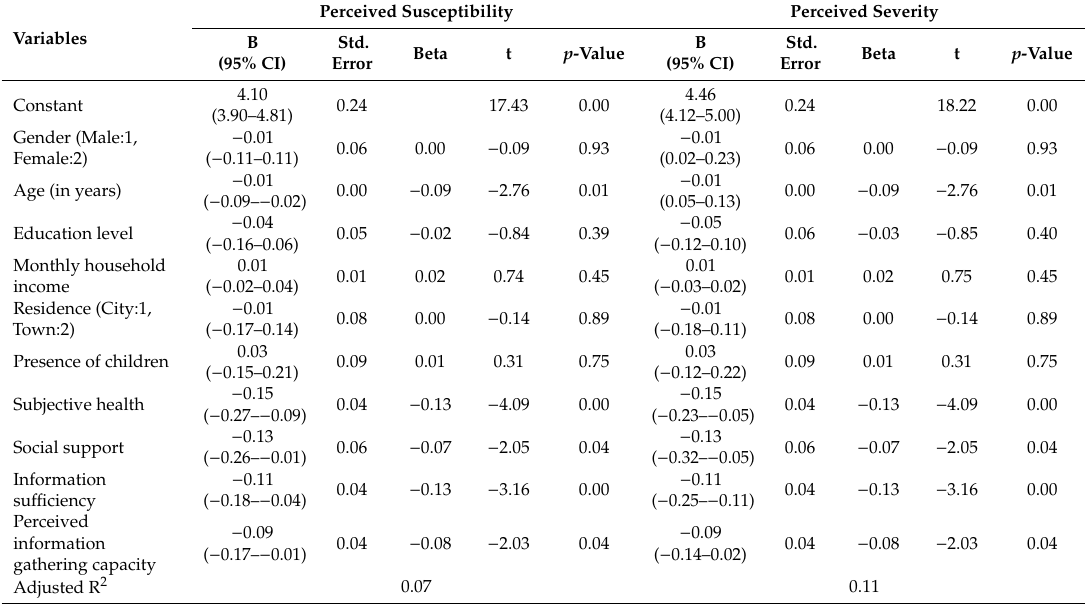
Table 3. Results of multivariate linear regression analysis of perceived risk for